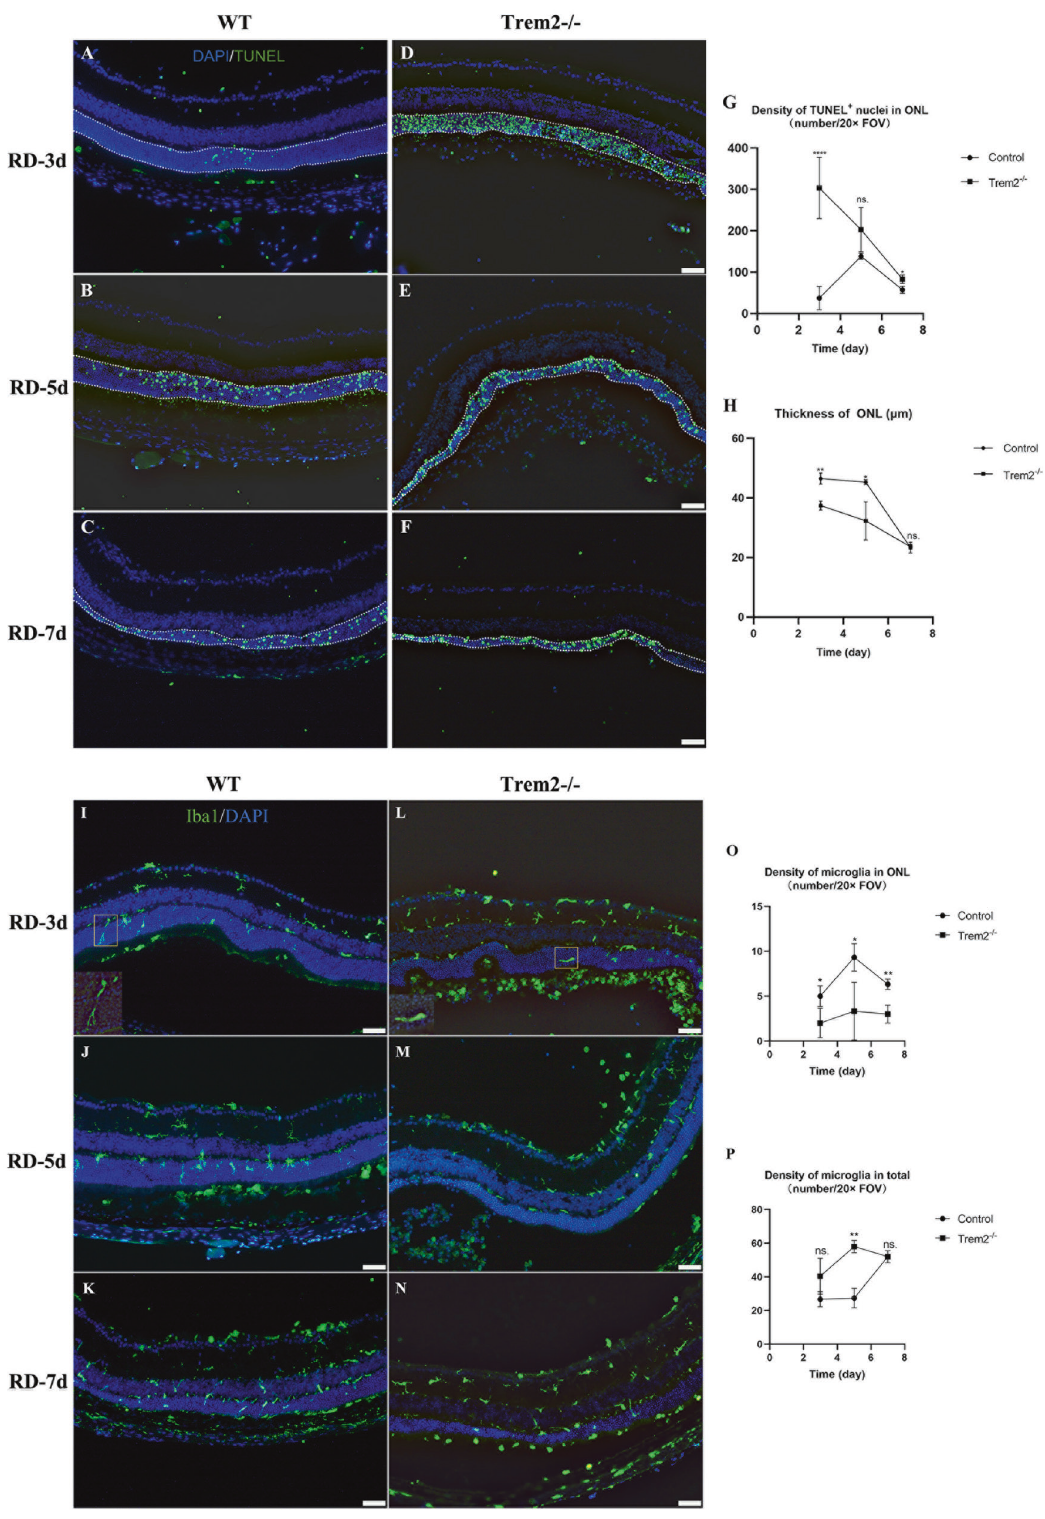
Fig. 3 TREM2 de fi ciency accelerates photoreceptor degeneration, and affects microglial cell in fi ltration and distribution following RD. Representative immuno fl uorescent images of TUNEL + nuclei from 3 d to 7 d post-RD in WT ( A – C ) and Trem2 − / − ( D – F ) mouse. Scale bar, 50 μ m. G , H Comparison of the number of TUNEL + nuclei and ONL thickness between WT and TREM2 − / − mouse retina at 3, 5, and 7 days post-RD. Representative immuno fl uorescent images of IBA1 + cells from 3 d to 7 d post-RD in WT ( I – K ) and Trem2 − / − ( L – N ) mouse. Scale bar, 50 μ m. O , P Comparison of the in fi ltration and distribution of IBA1 + cells between WT and Trem2 − / − mouse retina at 3, 5, and 7 days post-RD. Data was curated and presented as described in Fig. 2. Three to six animals were used for each time point in each